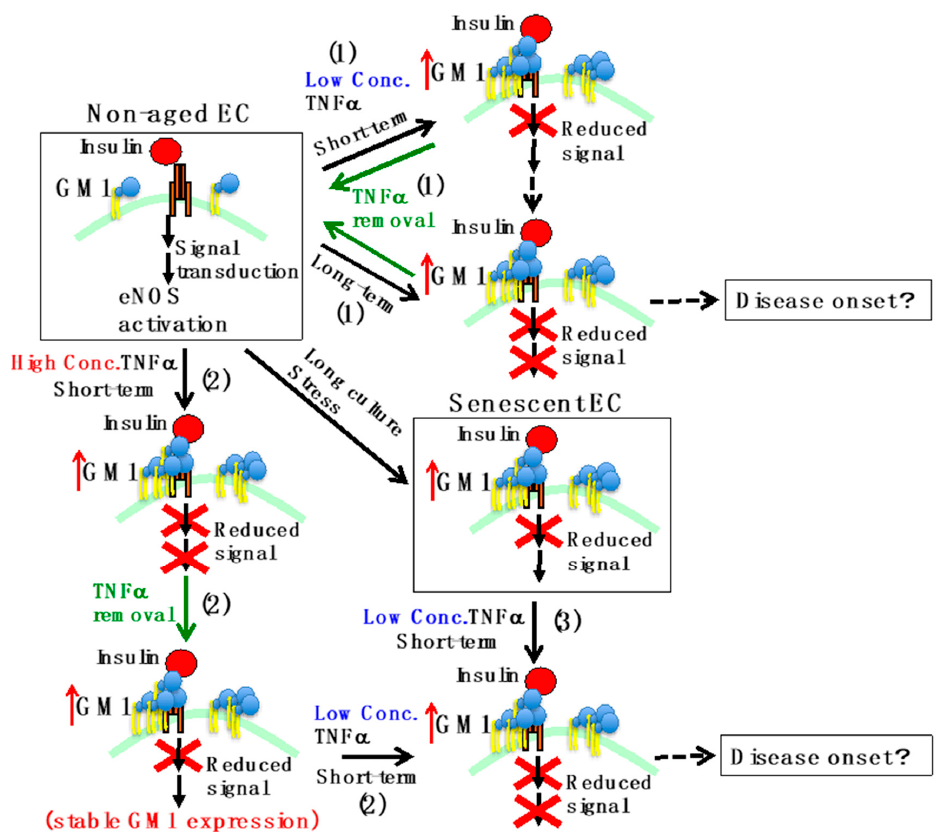
Figure 2. Schematic representation of insulin resistance in ECs. In non-aged ECs, activation of eNOS occurs by insulin stimulation. On the other hand, in senescent ECs, which underwent multiple cell divisions or oxidative stress, GM1 levels increase and insulin signaling decreases. The e ff ects of TNF α are the following. 1) When short-term stimulation (acute inflammation) with low concentrations of TNF α is performed on non-aged ECs, insulin signaling decreases and GM1 levels increase. Further stimulation for a long period of time (chronic inflammation) leads to decreased eNOS expression. Removing the stimulus restores physiological conditions. 2) Short-term stimulation in non-aged ECs with high concentrations of TNF α leads to a decrease in the expression of eNOS. Even if the stimulus is removed, the increase in GM1 levels and the decrease in insulin signaling are stable. When GM1 levels are increased, short-term stimulation with low concentrations of TNF α results in decreased expression of eNOS. 3) In senescent ECs, the expression of eNOS decreases even upon short-term stimulation with low concentrations of TNF α , because GM1 levels are already increased. A continued decline in eNOS levels may lead to disease onset due to chronic reduction of NO